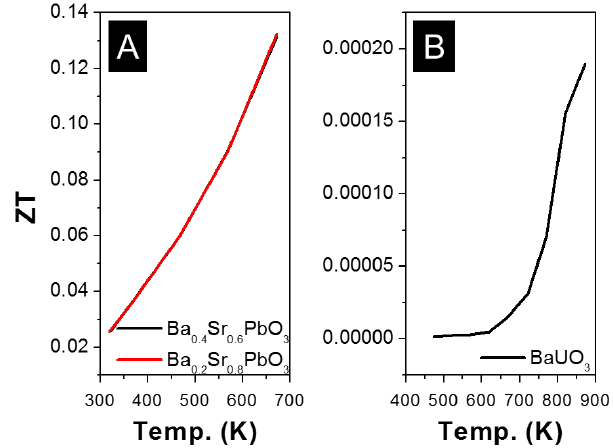
Figure 11. ZT value of ( A ) APbO 3 and ( B ) AUO 3 based oxide perovskite materials, all the materials are n-type semiconductors.